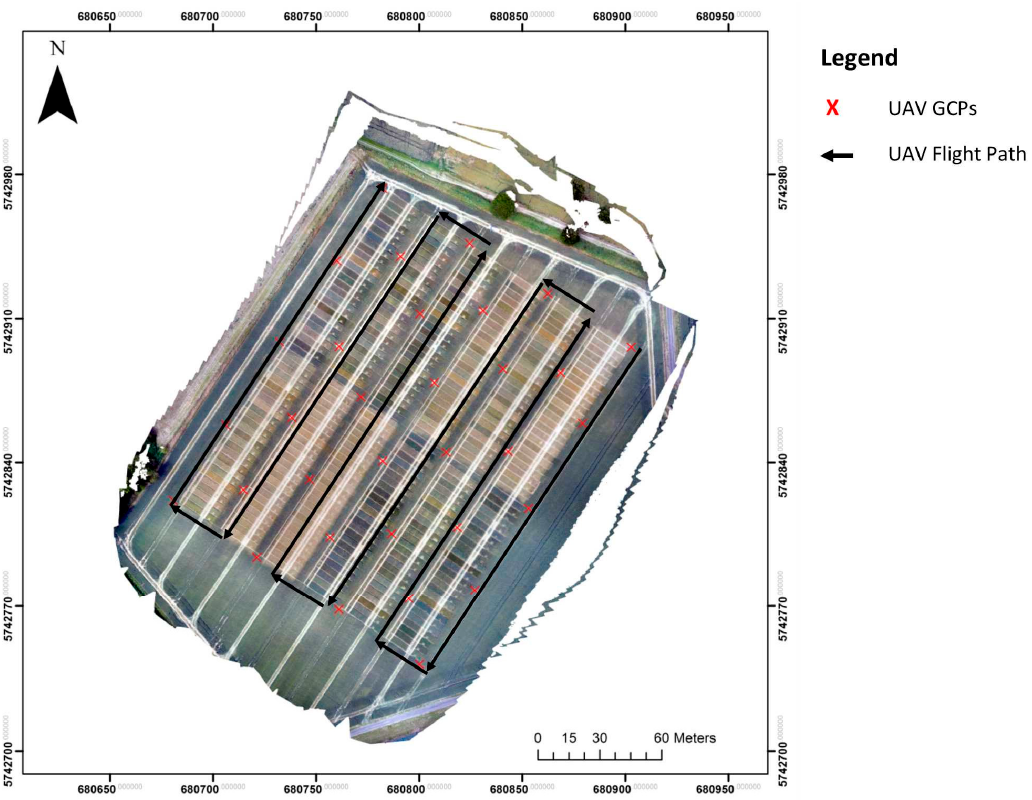
Table 8. Agisoft processing parameters used in the 2015 study. The model resolution provided is the resolution reported by Agisoft Photoscan.